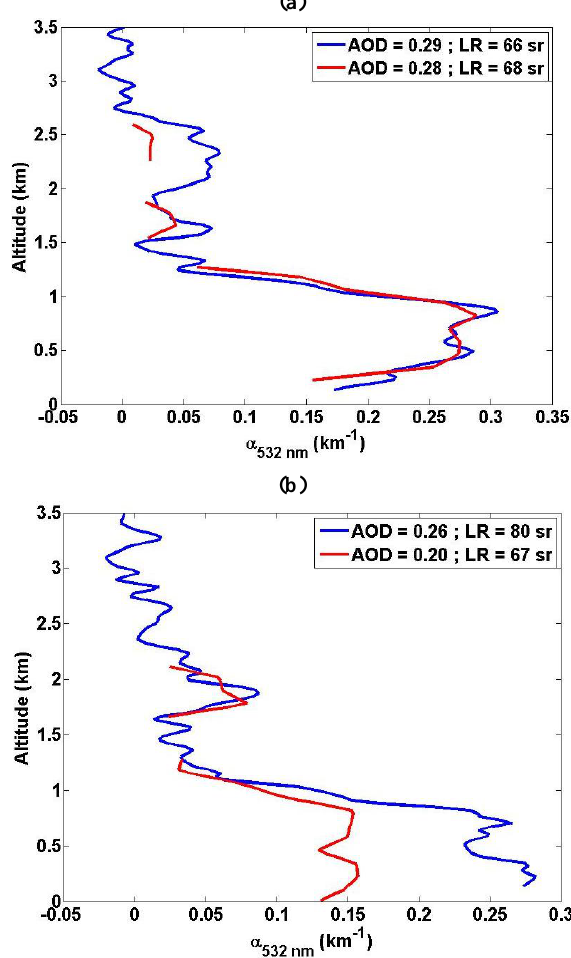
Fig. 10: Mean vertical profiles of aerosol extinction coefficient at 532 nm on (a) 15 September 2007 at 12:30 GMT and (b) 8 September 2007 at 12:24 GMT. The aerosol extinction coefficient is obtained from CALIOP level-2 operational product (red line) and from CALIOP level-1 data inverted with the LR retrieved from the synergy with MODIS (blue line).